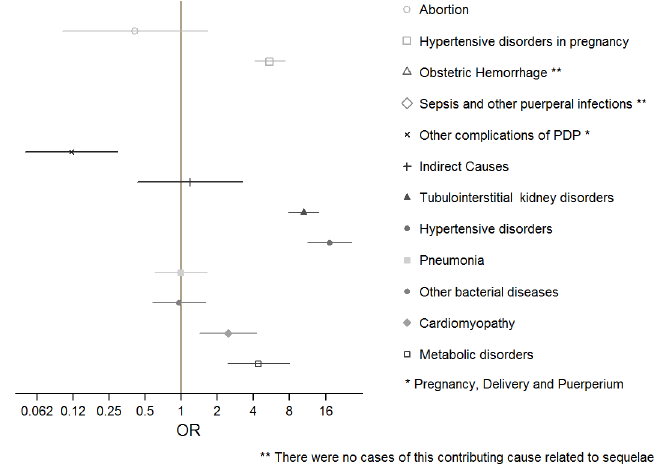
Fig 4. Odds ratios (OR) and 95% confidence intervals for causes related to deaths from sequelae of obstetric causes (deaths occurring 365 days or more after the end of pregnancy). Mexico, 2010 – 2013.